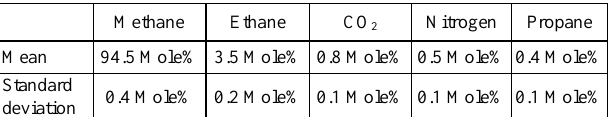
Table 3: Composition of the used gas (values of 7 gas